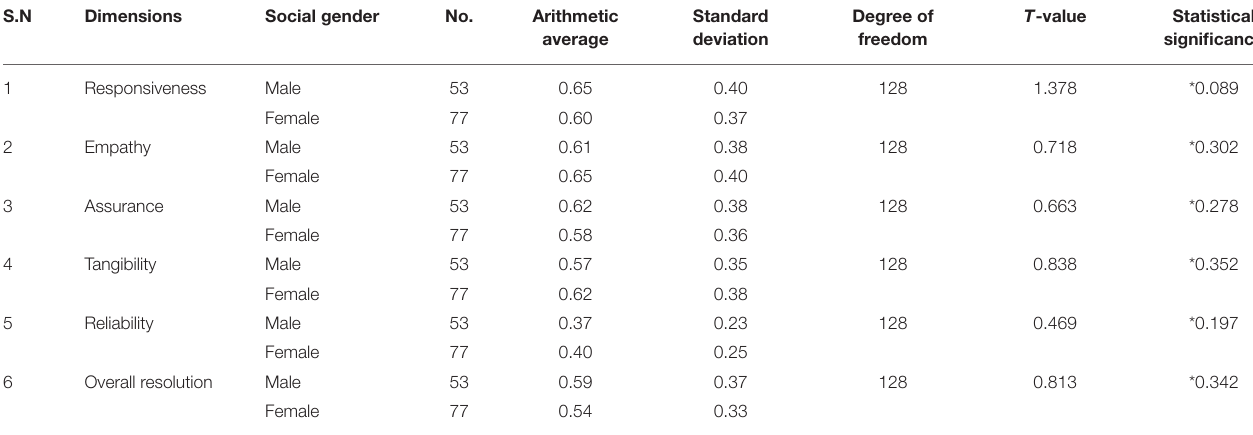
TABLE 5 | T -test shows differences in the sample individuals’ responses according to the gender variable by calculating the gap.